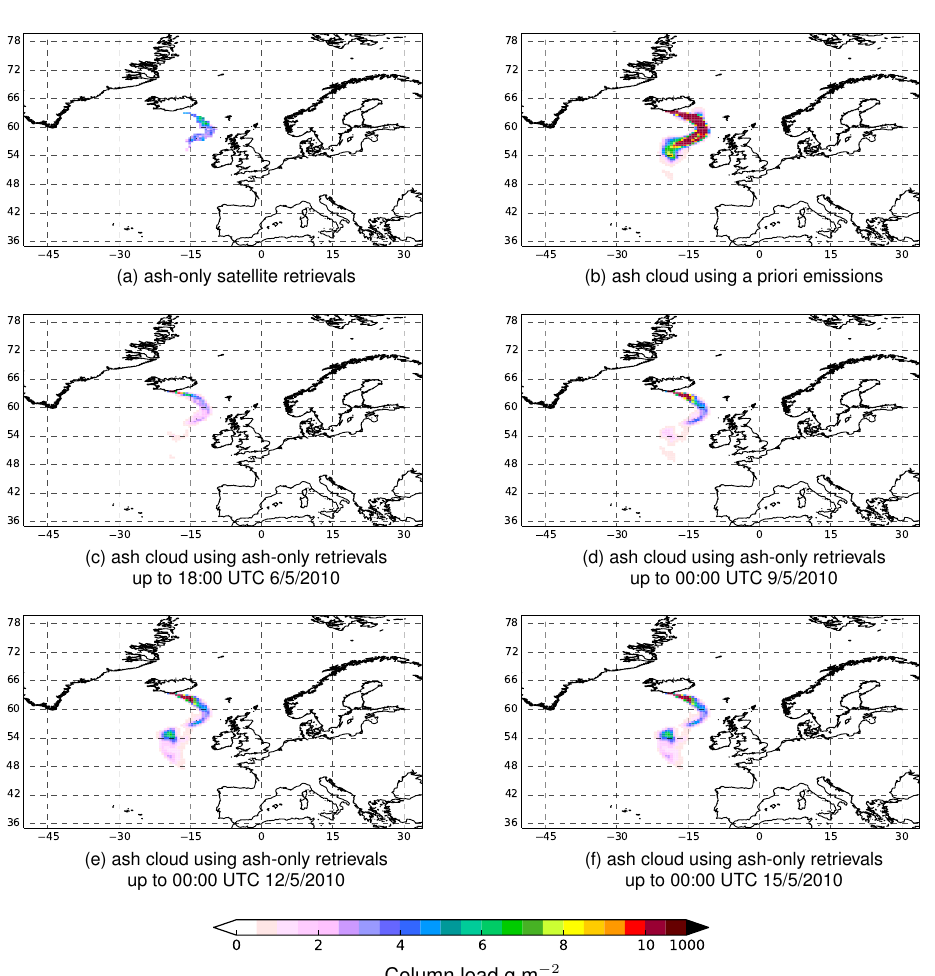
Figure 5. The Eyjafjallajökull ash cloud (column load contribution from the 1–30 µ m size range, g m − 2 ) averaged between 17:00 UTC and 18:00 UTC on 6 May 2010: ( a ) as observed by satellite (ash only); ( b ) as predicted by NAME using the a priori emissions; and ( c – f ) as predicted by NAME using inversion emission profiles determined using the ash-only satellite observations available up to various cut-off